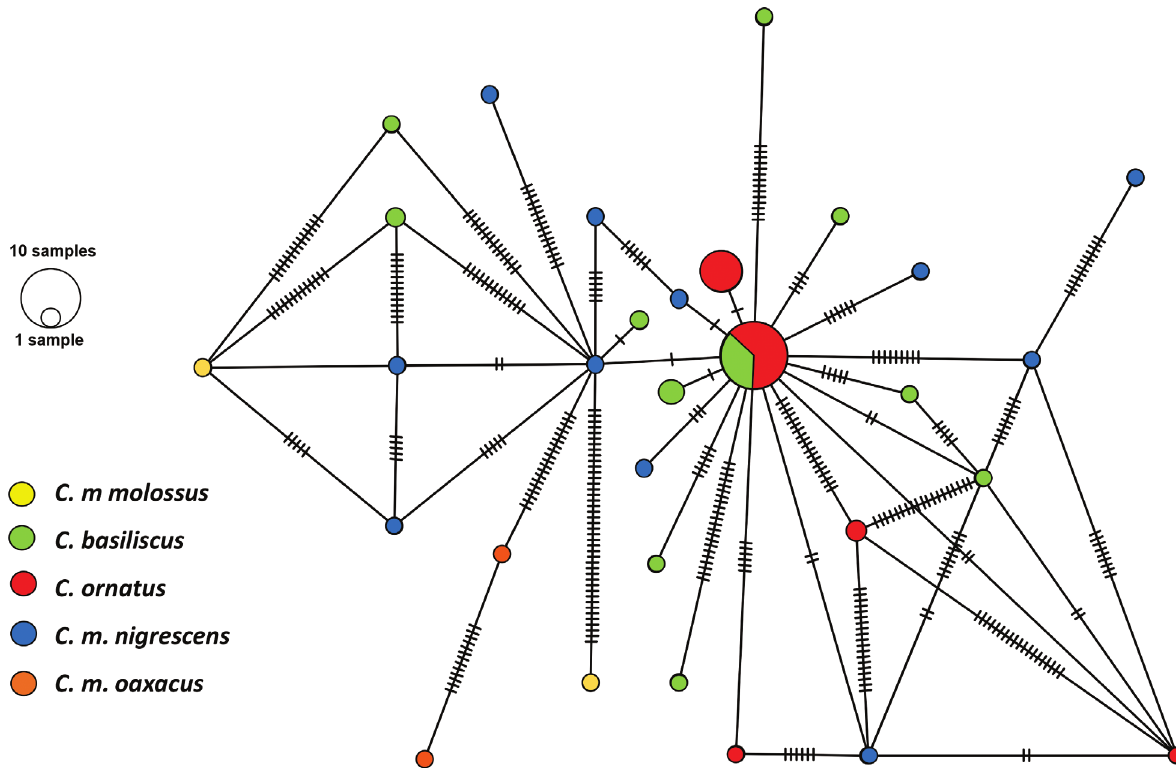
Figure 3. Minimum Spanning network constructed with RAG1 phased haplotypes. Sizes of colored dots are in agreement with haplotype abundance in the sample and colors represent the main clades recovered along phylogenetic inference (excepting C. totonacus